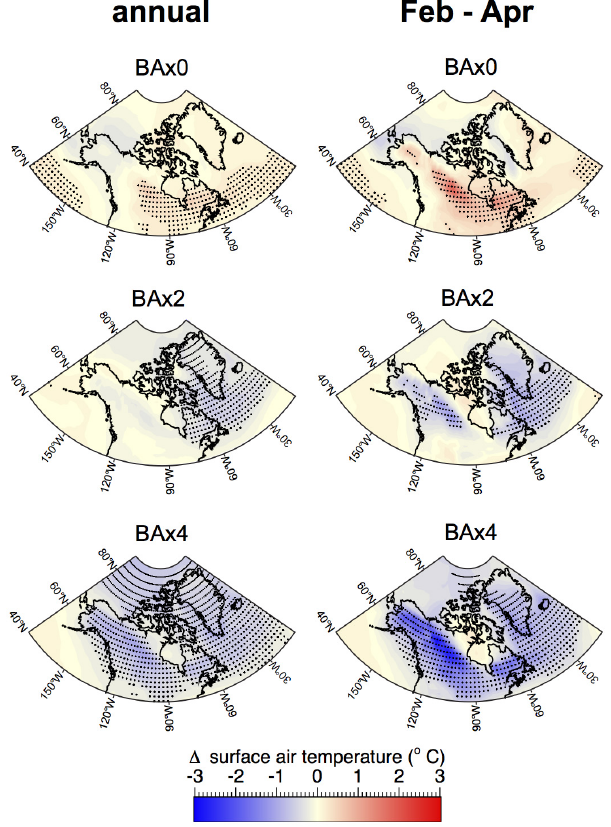
Fig. 7. Annual and February–April temperature anomalies across high-latitude North America, Greenland, and the surrounding ocean. Stipples represent 95% statistical significance.